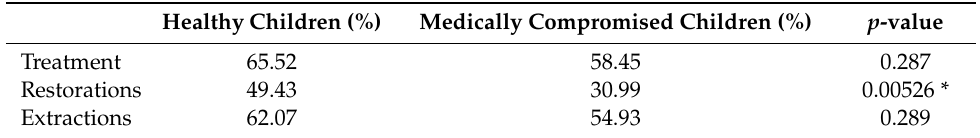
Table 2. The percentage primary dentition treatment